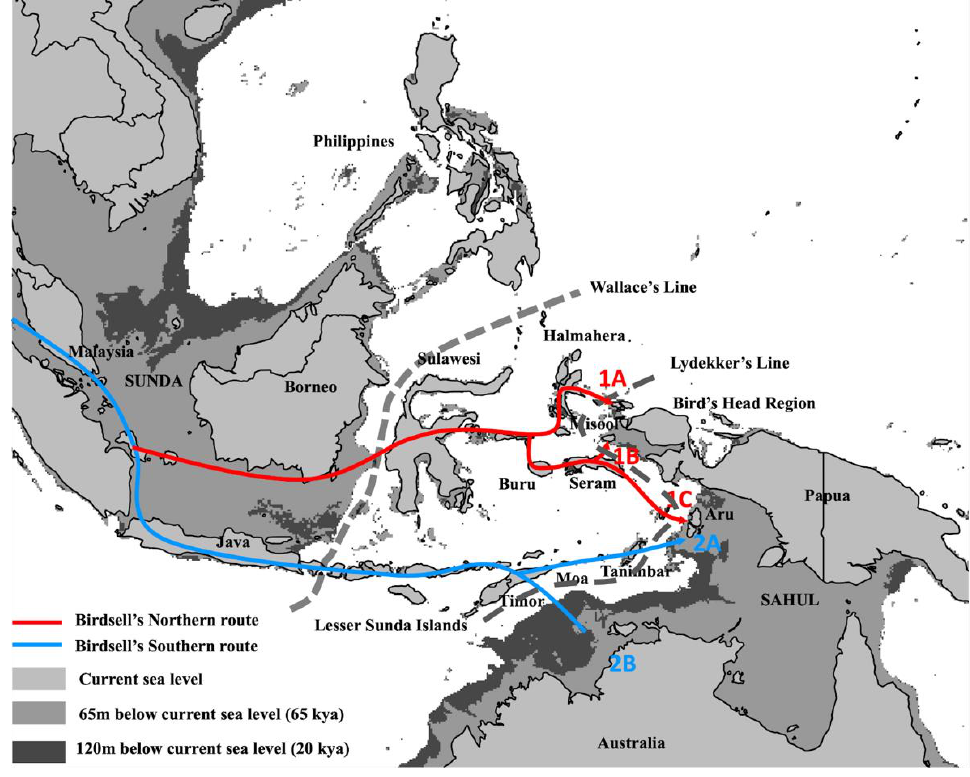
Figure 1. Map of Wallacea and Sahul with palaeo-geographic reconstructions at lower sea levels Wallacea lies between the former continents of Sundaland (to the west of Wallace’s Line) and Sahul (lying east of Lydekker’s Line), requiring incoming human migrants to undertake a series of interis- land movements across the archipelago before arriving in Sahul (historical coastlines at multiple time periods are indicated by different grey shades). Two main routes through the Wallacea have been identified [19]. Migration along the Northern Route (red arrows) would have brought AMH